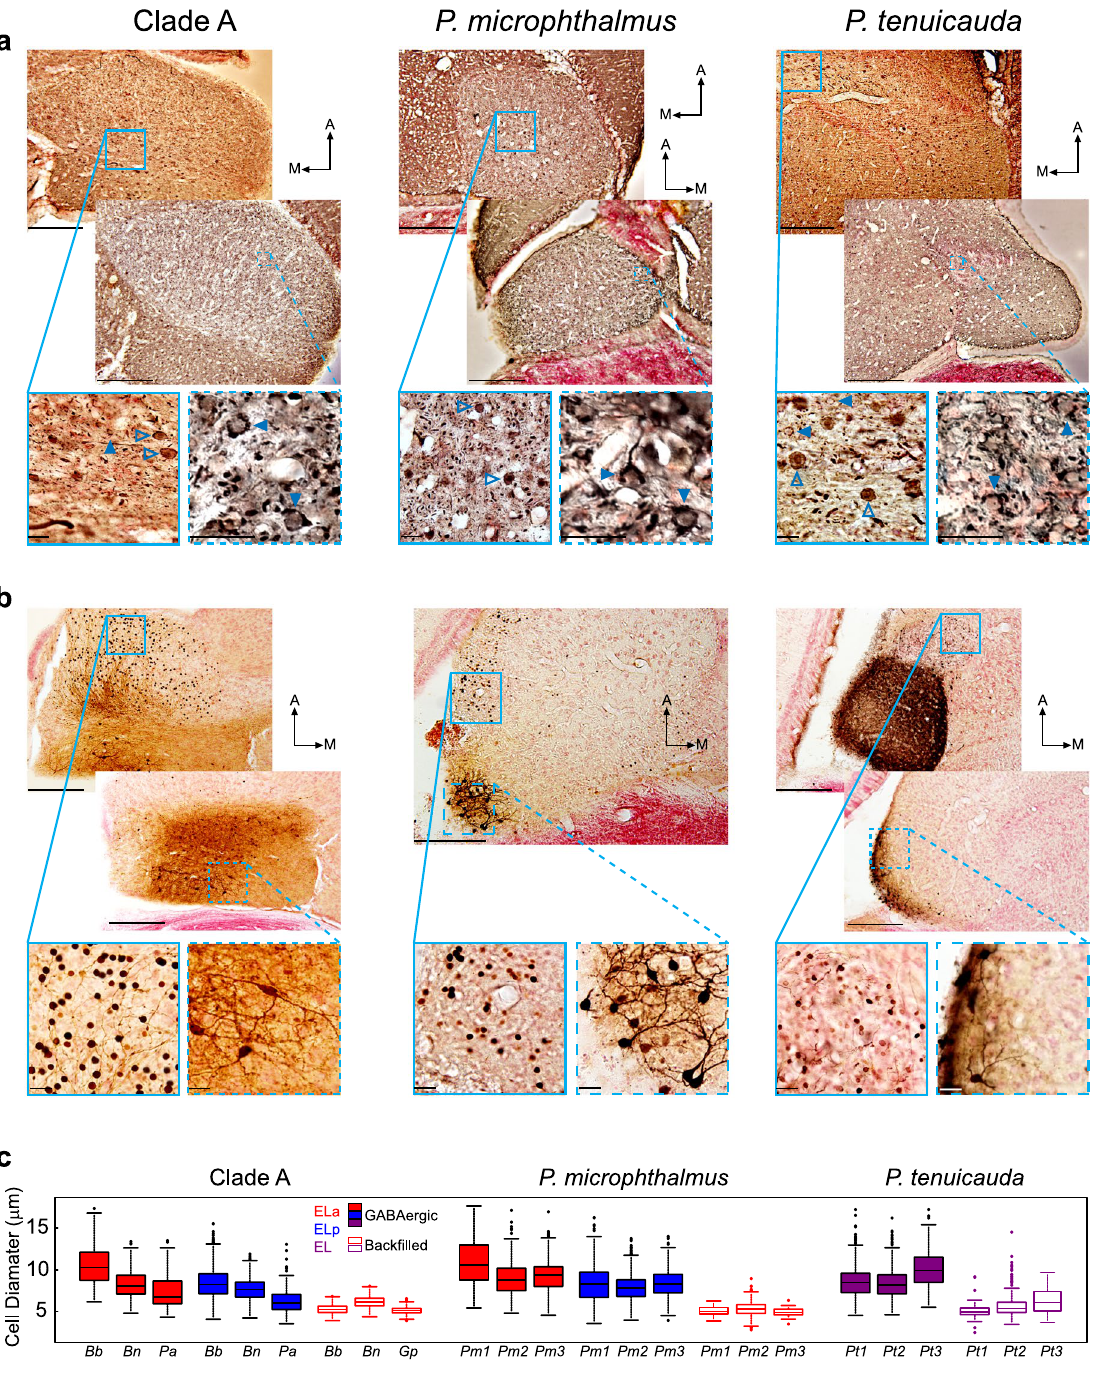
Figure 4. The three same basic types of neurons are found in ELa/ELp of clade-A species and P . microphthalmus , and in EL of P . tenuicauda . ( a ) GABA immunohistochemistry revealed inhibitory neurons in ELa and ELp of clade-A species (left) and P . microphthalmus (center), and throughout EL and the lateral lemniscus of P . tenuicauda (right). The images on the bottom show enlarged views taken from the boxes and show stained somas (open arrowheads) and terminals onto unstained cell bodies (filled arrowheads). ( b ) Iontophoretic injections in ELp of clade-A species and P . microphthalmus , and in the posterior end of EL of P . tenuicauda reveal multipolar cells in ELp and the posterior end of EL, and backfilled adendritic small cells in ELa and the anterior end of EL. Images on the bottom are enlarged views taken from the boxes and show stained somas of backfilled small cells (left), and multipolar cells (right). All photomicrographs in ( a ) and ( b ) are from 50- µ m horizontal sections through the midbrain. ( c ) Cell diameters of GABAergic cells (filled boxes) and backfilled cells (open boxes) after injections of neuronal tract tracers in ELp and the posterior end of EL. Cell diameters in ( c ) were measured in ELa (red) and ELp (blue) of clade-A species and P . microphthalmus , and in EL (purple) of P . tenuicauda . Data of GABAergic cells were obtained from one B . brachyistius ( Bb ), one B . niger ( Bn ), and one P . adspersus ( Pa ) for clade A, from three individuals of P . microphthalmus ( Pm1 - 3